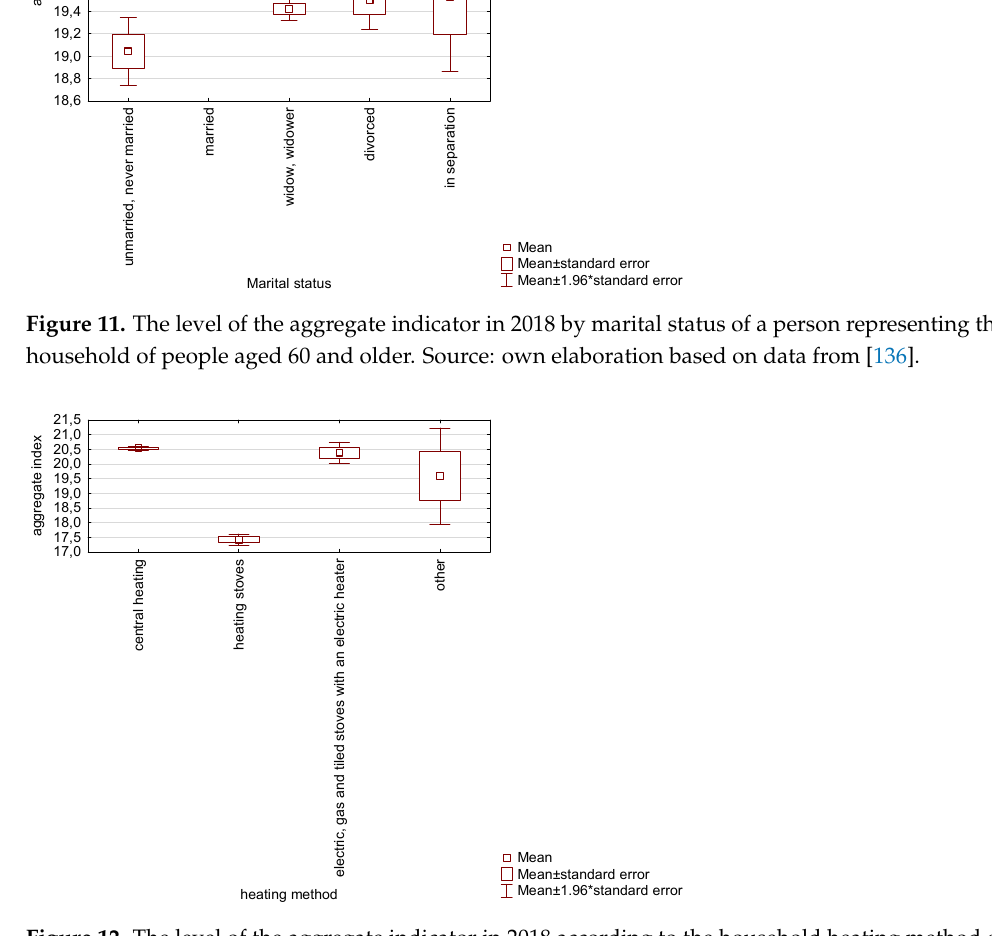
of people aged 60 and older. Source: own elaboration based on data from [136]. people aged 60 and older. Source: own elaboration based on data from